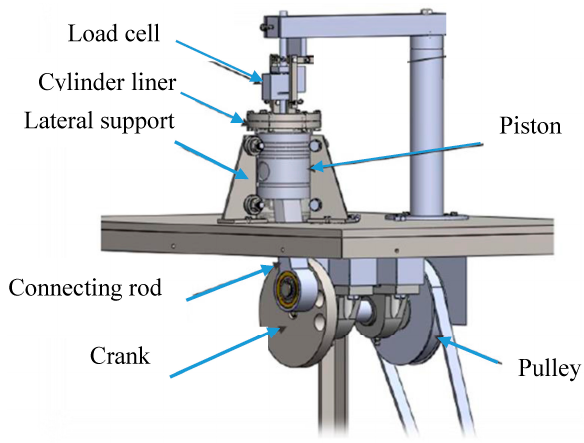
Figure 1. Schematic of the test setup [16].